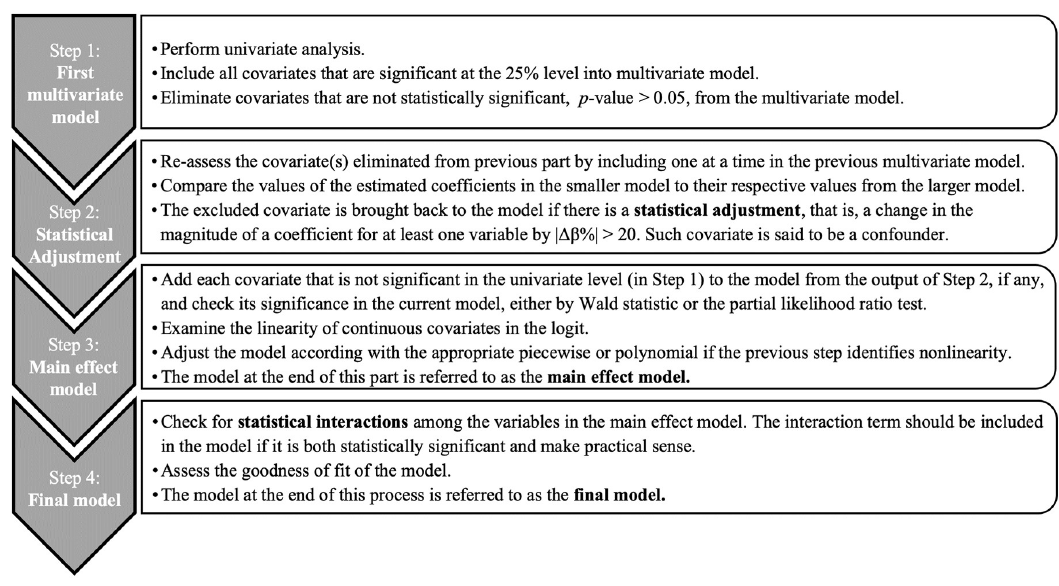
Fig 1. Model-building strategy using method of purposeful selection developed by Hosmer et al. [16].